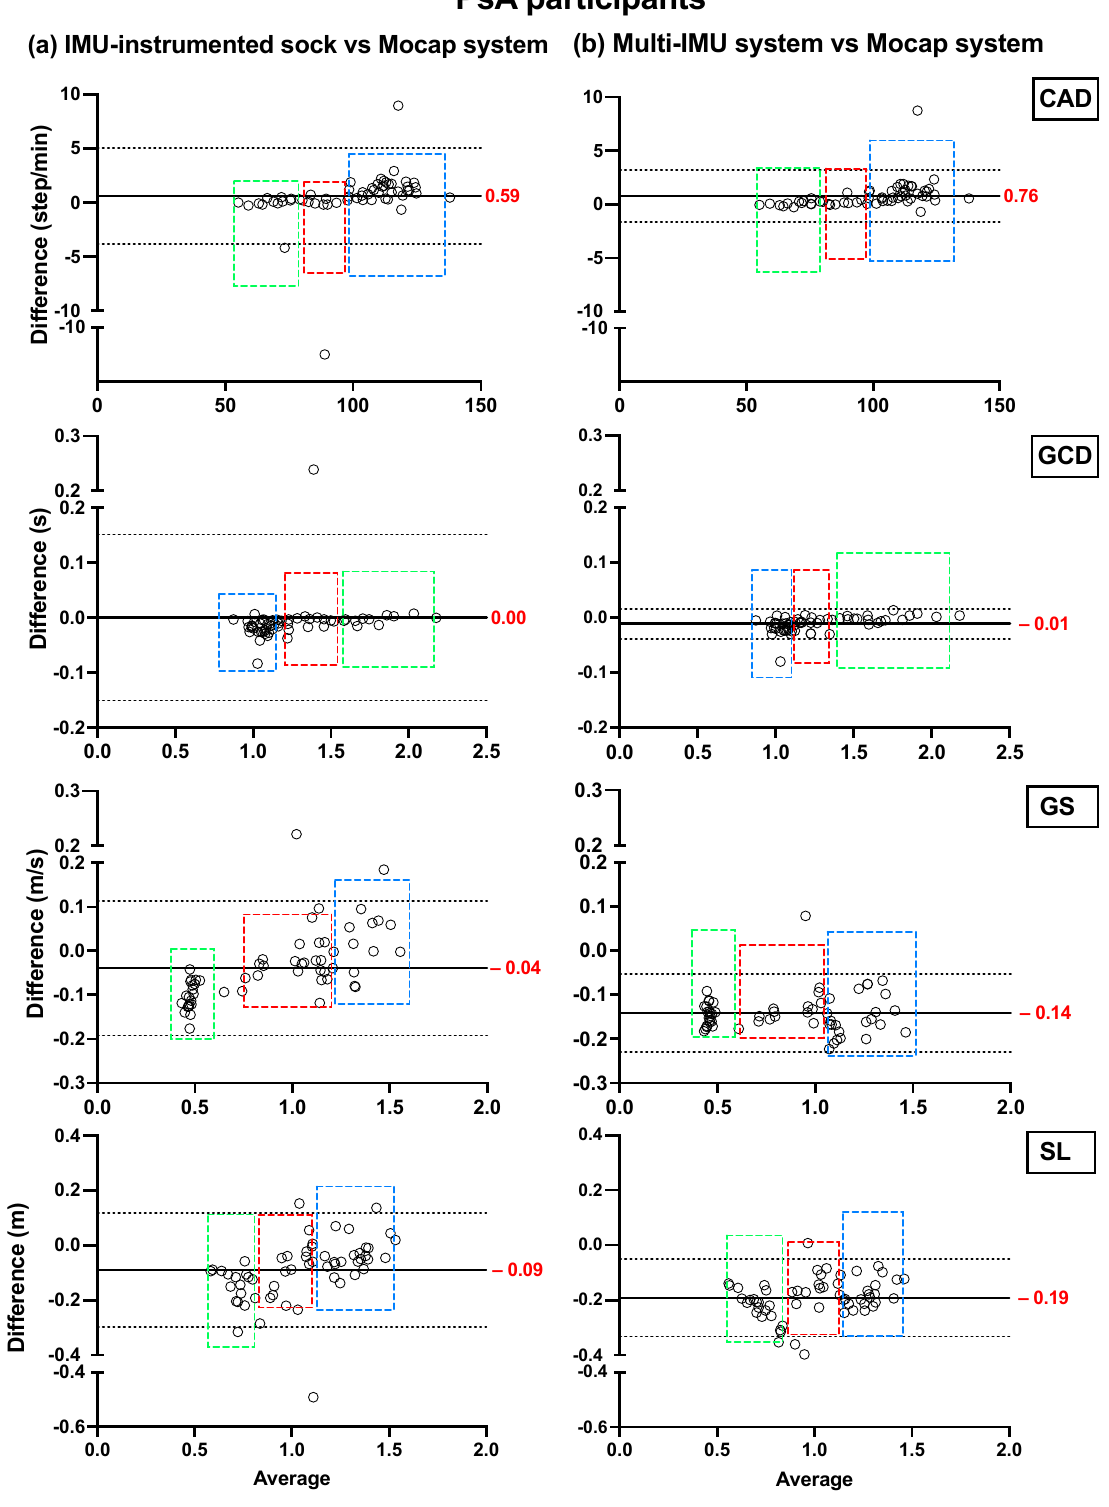
Figure 3. Concurrent validity. Bland–Altman plots of the differences between ( a ) the TEADRIP algorithm applied to the IMU-instrumented sock recordings and the Mocap system, and between ( b ) the Mobility Lab system and the Mocap system during two-minute treadmill walking at different speeds in PsA patients (n = 21, one session). Cadence (CAD), gait cycle duration (GCD), gait speed (GS), stride length (SL), and Motion capture system (Mocap). The solid lines indicate the mean test-retest differences (bias) and the dashed lines indicate the upper and lower 95% limits of agreement (1.96 SD of the bias). Dashed green, red, and blue squares represent the observations for slow, normal, and fast speeds,